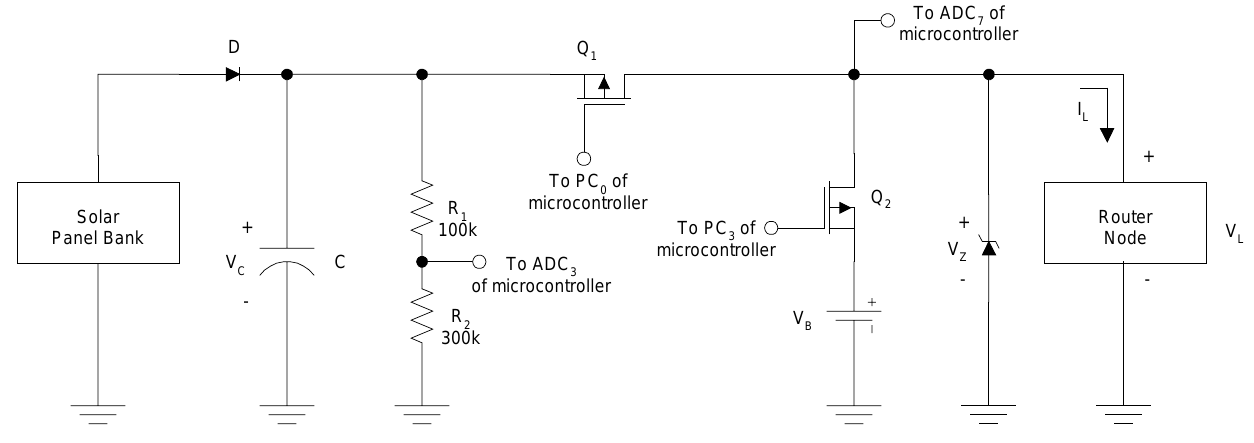
Figure 3. Router node solar energy harvesting circuit with battery